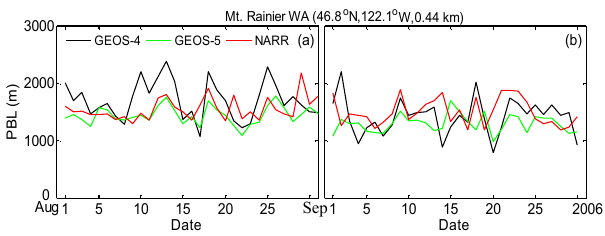
Figure 9. Same as Figure 7, but from GEOS-4 (black line), GEOS-5 (green line), and NARR (red line) for 2006.